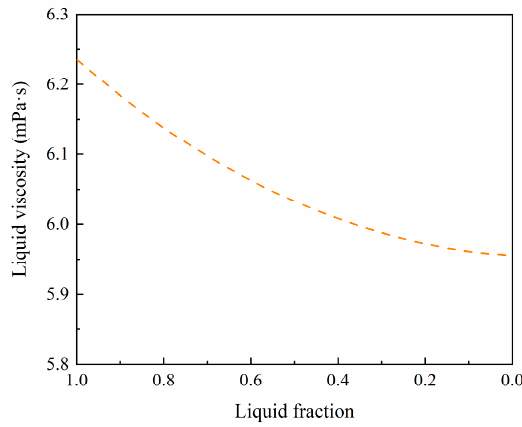
Figure 7. Variation of liquid viscosity during solidification.